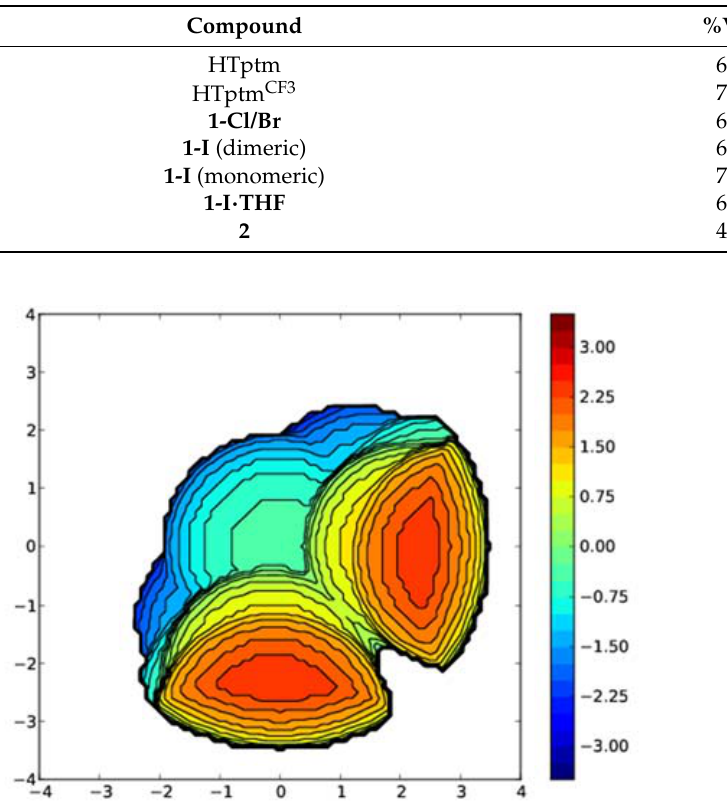
Figure 10. Steric map of the Bptm ligand in 2. Generated from buried volume calculations with a coordination sphere of 3.5 Å.